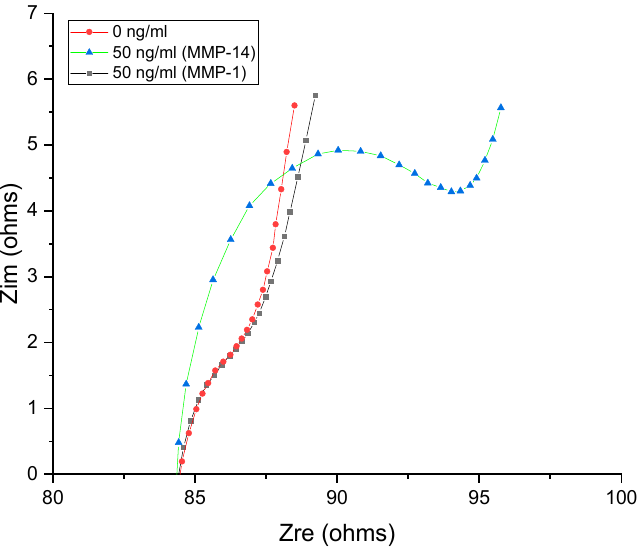
Figure 5. EIS response for the inhibitor loaded CNT after individual interaction with 50 ng · mL − 1 of MMP-1 and MMP-14 in PBS (pH 7.40) containing 10 mmol · mL − 1 of K 4 [Fe (CN) 6 ] − 10 mmol · mL − 1 of K 3 [Fe (CN) 6 ] − and 10 mmol · mL − 1 of NaCl. The inhibitor loaded CNT showed specificity to MMP-14 (applied potential of +0.20 V, from 50 kHz to 500 Hz, amplitude 50 mV).